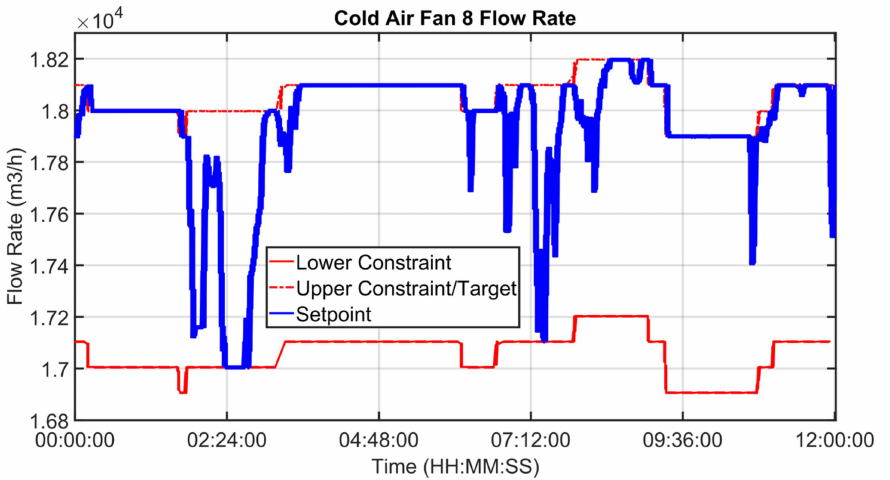
Figure 35. Grate cooler APC system: field results (cold air fan 8 flow rate